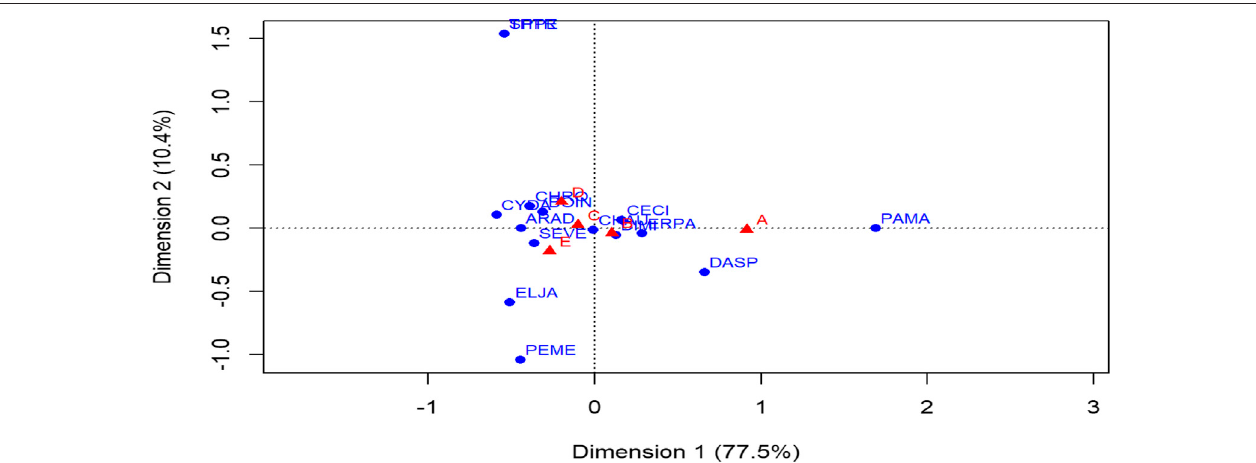
FIGURE 2 | CA ordination of grass species abundance by thinning plots in Borana rangelands of Ethiopia. “ Dimension 1 ” represents ‘ Columns, ’ “ Dimension 2 ” represent ‘ Rows. ’ Reddiamonddenotesplots:(A) = 0%,(B) (cid:2) 25%,(C) (cid:2) 50%,(D) (cid:2) 75%,and(E) = 100%.Bluedotspeci fi esspecies.Speciesabbreviationsare:ARAD, Aristida adscensionis ; BOIN, Bothriochloa insculpta ; CECI, Cenchrus ciliaris ; CHRO, Chloris roxburghiana ; CHAU, Chrysopogon aucheri ; CYDA, Cynodon dactylon ; DASP, Dactyloctenium species ; DIMI, Digitaria milanjiana ; ELJA, Eleusine jaegeri ; ERPA, Eragrostis papposa ; PAMA, Panicum maximum ; EME, Pennisetum mezianum ; SEVE, Setaria verticillata ; SPPE, Sporobolus pellucidus , and THTR, Themeda triandra .